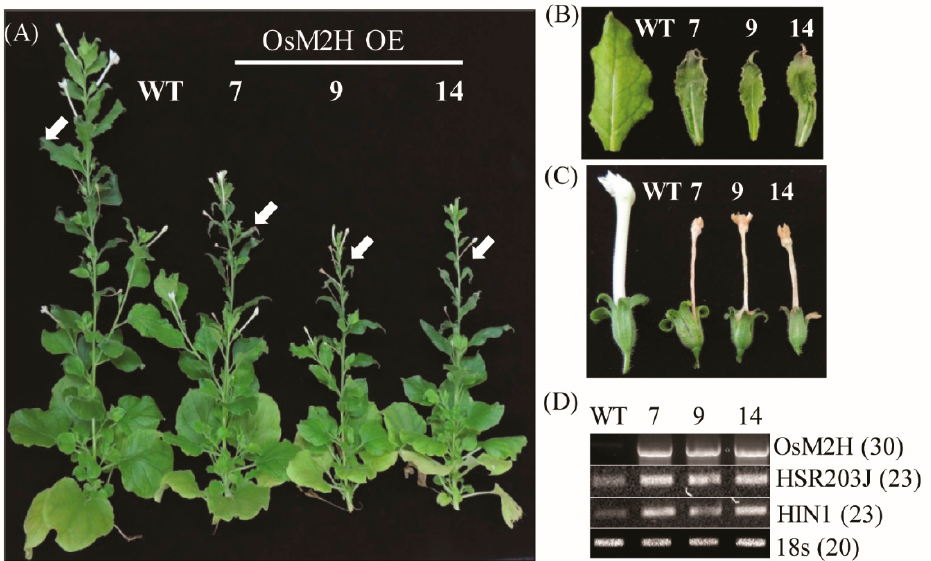
Figure 1. Overexpression of OsM2H caused dwarfism and spontaneous cell death in transgenic tobacco ( Nicotiana benthamiana ). ( A ) Phenotypes of OsM2H overexpression (OE) in tobacco. Tobacco plants grown in soil under long-day growth conditions (16 h light/8 h dark) at 28 °C for up to 12 weeks were photographed. ( B) Phenotypes of upper tobacco leaves, indicated by arrows in ( A ). ( C ) Flower phenotypes. ( D ) Reverse-transcription polymerase chain reaction (RT-PCR) analysis results. The GenBank accession numbers of OsM2H, HSR203J , and HIN1 are AK119413, AB091430, and Y07563, respectively. Numbers in parentheses indicate the number of PCR cycles.